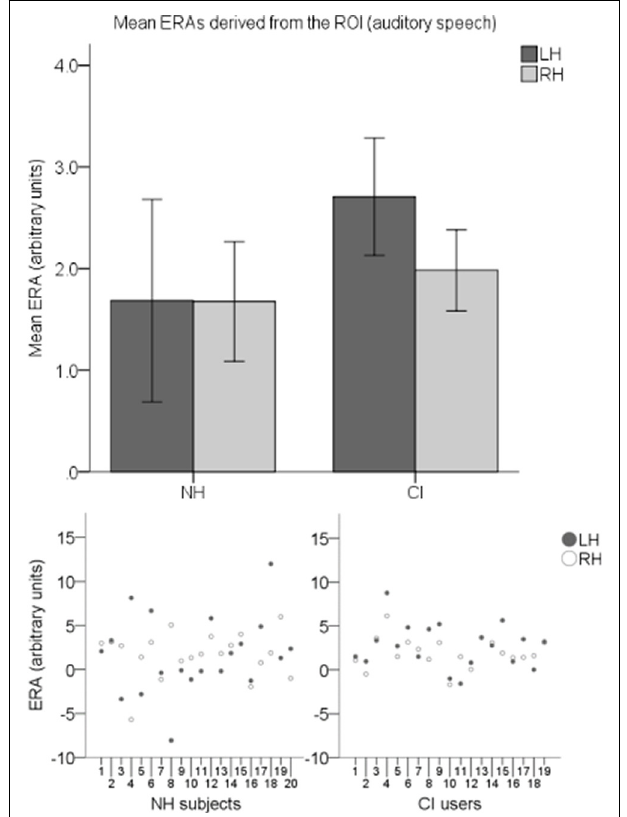
FIGURE 9 | Individual estimated response amplitudes (ERAs) and group level means ( N = 39) derived from the ROI for the visual speech condition. The bar chart shows mean ERAs for each group corresponding to channels 9, 10, and 12 in the LH and channels 20, 21, and 23 in the RH. Error bars show ± 1 standard error of the mean. Scatterplots showing individual ERA values are displayed underneath for each group.